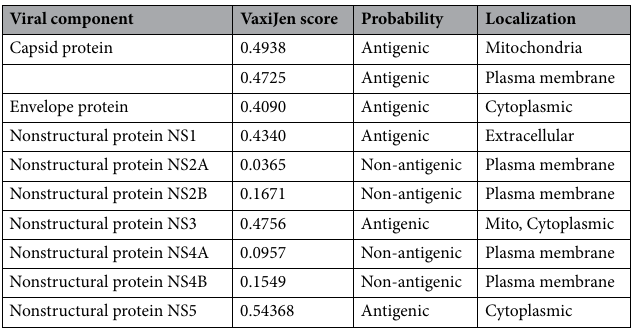
Table 3. Antigenicity prediction of dengue virus proteins. (Threshold = 0.4 with tumor model).